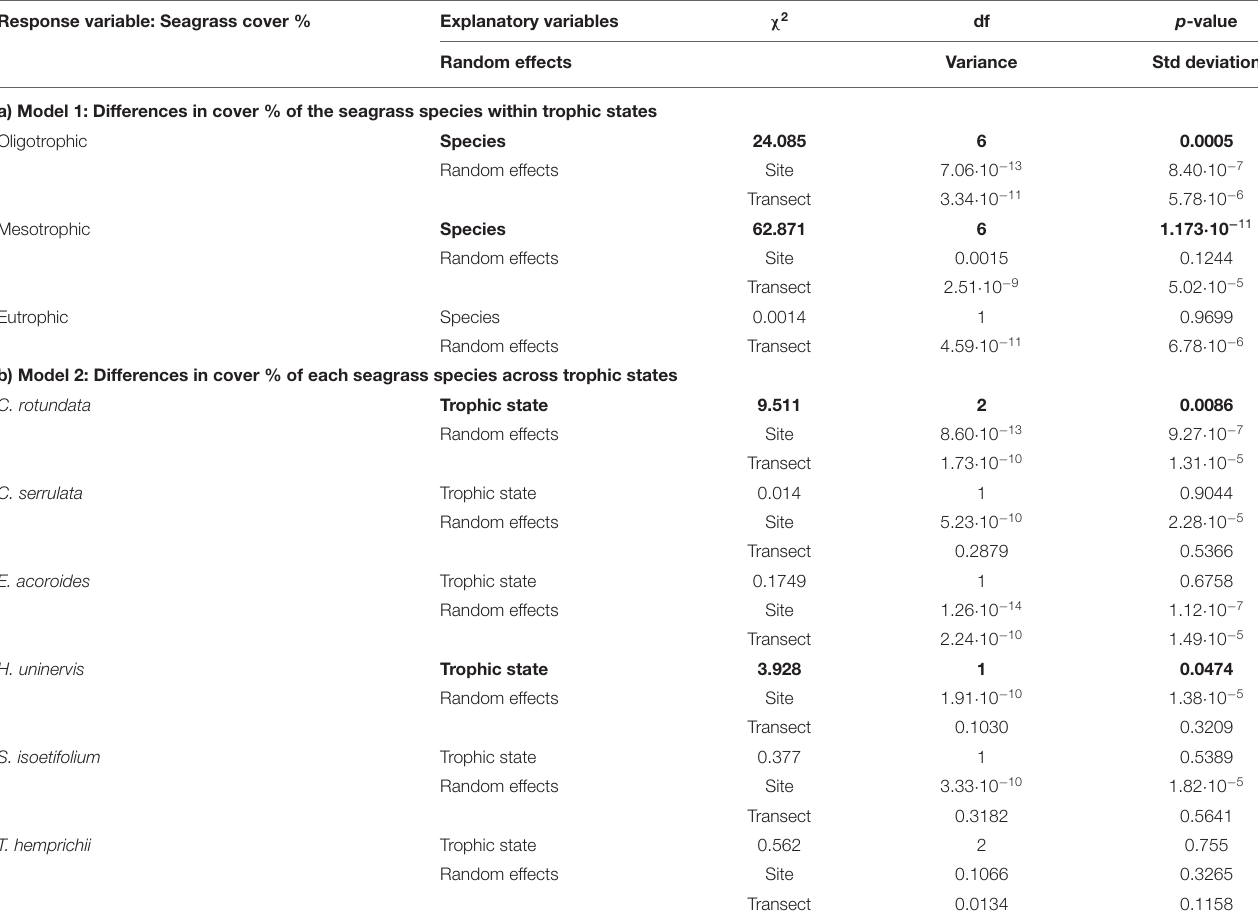
TABLE 2 | Complete output of Models 1 and 2 assessing (a) Model 1: Differences in cover % of the seagrass species within trophic states and (b) Model 2: Differences in cover % of each seagrass species across trophic states. Response variable: Seagrass cover